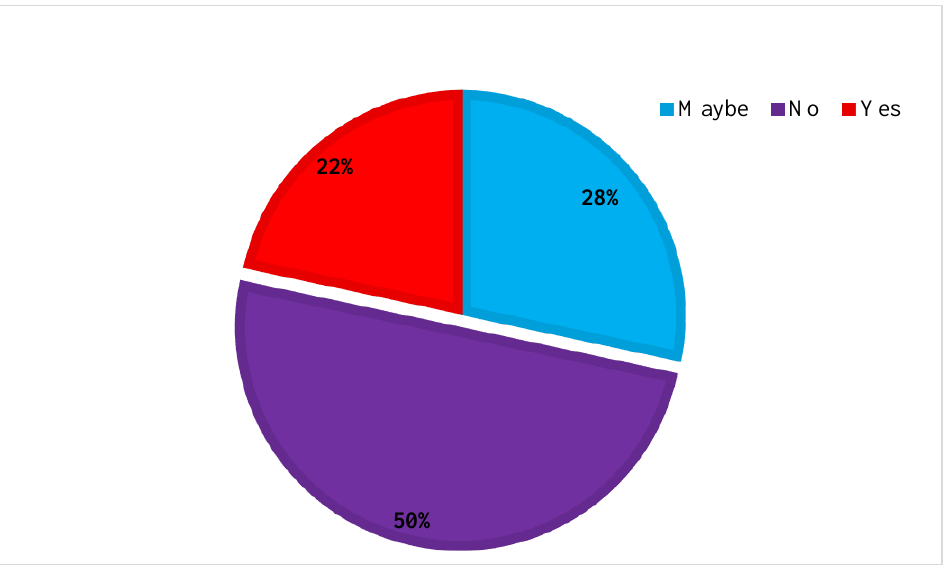
Figure 12. Preference for genetically modified foods (source: author’s construct, 2019).